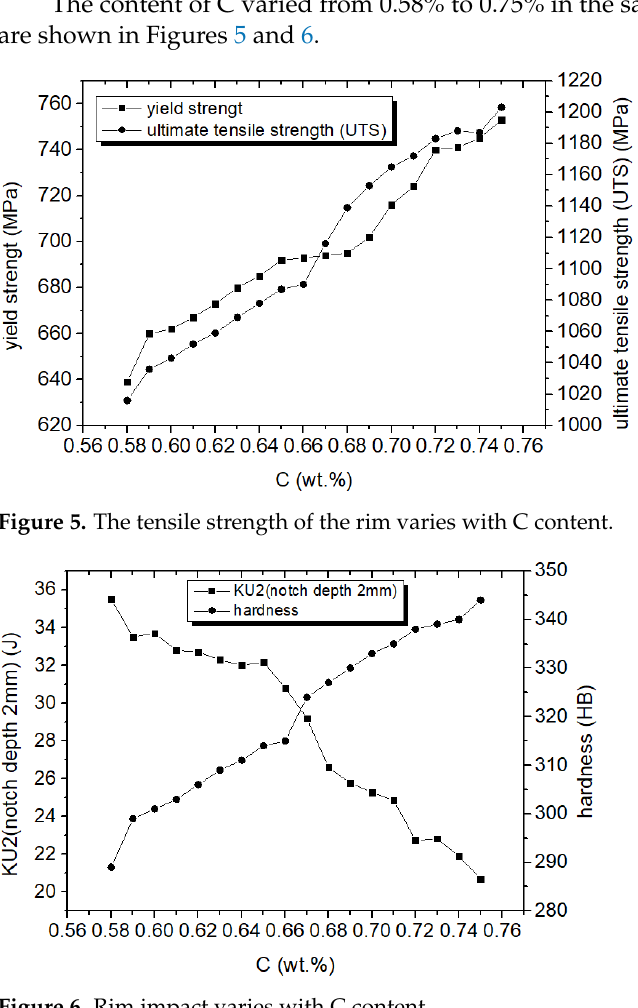
4 of 11 Figure 4. Diagram of steel plate performance inspection.